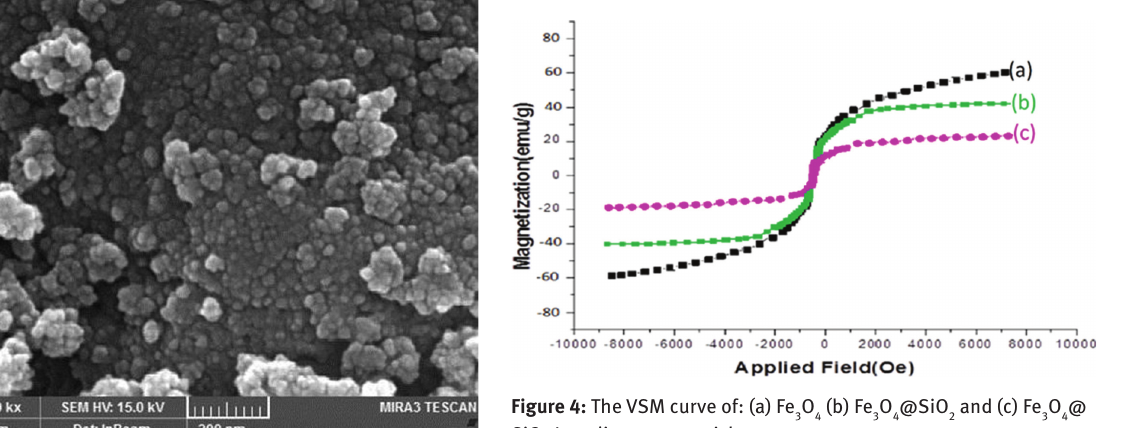
O (b) Fe O @SiO and (c) Fe 3 4 3 4 2